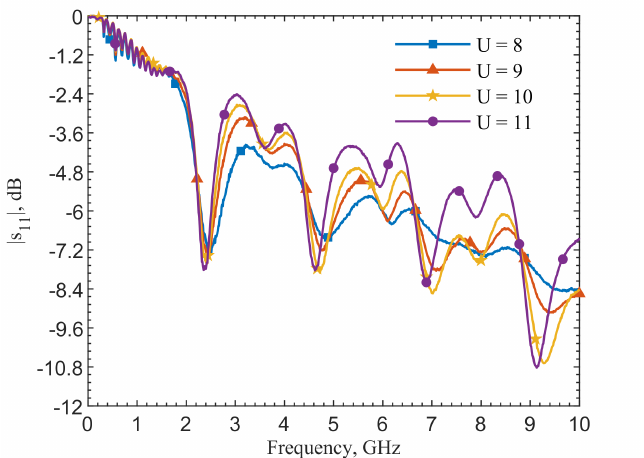
Figure 4. Comparison of measurements for loop resonators with U from 8 to